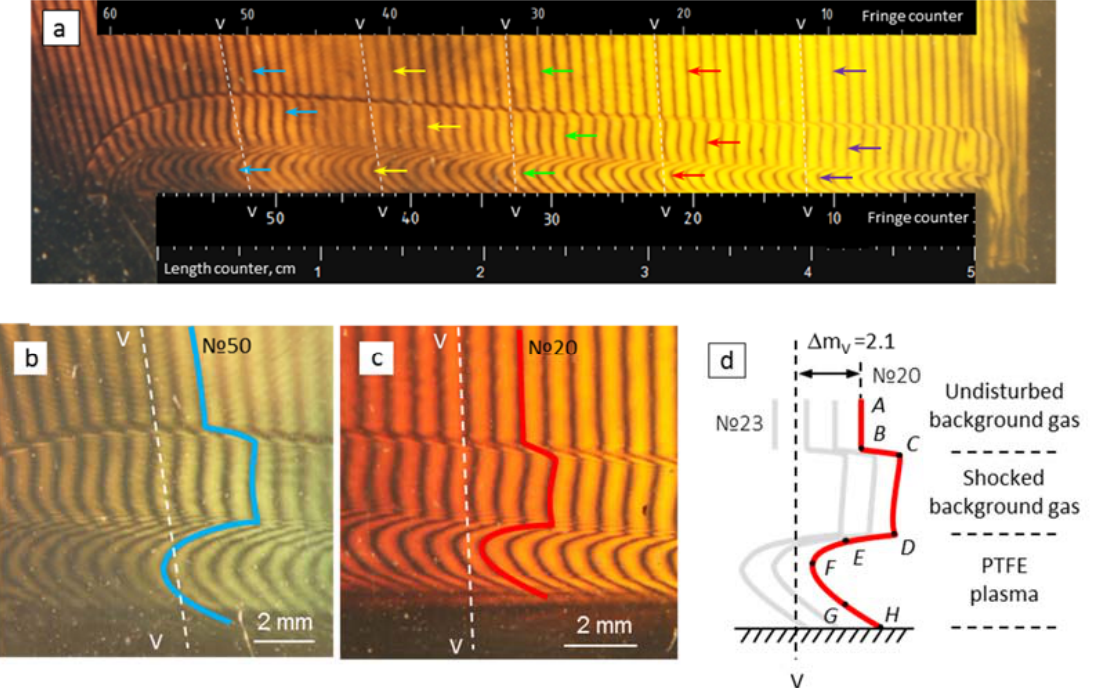
Figure 7. Interferogram of gas-dynamic response ( a ) with detailed fringe trends for #50 ( b ), #20 Figure 7 . Interferogram of gas ‐ dynamic response ( a ) with detailed fringe trends for #50 ( b ), #20 ( c ) ( c ) and reconstructed response structure for #20 ( d and reconstructed response structure for #20 ( d ) .